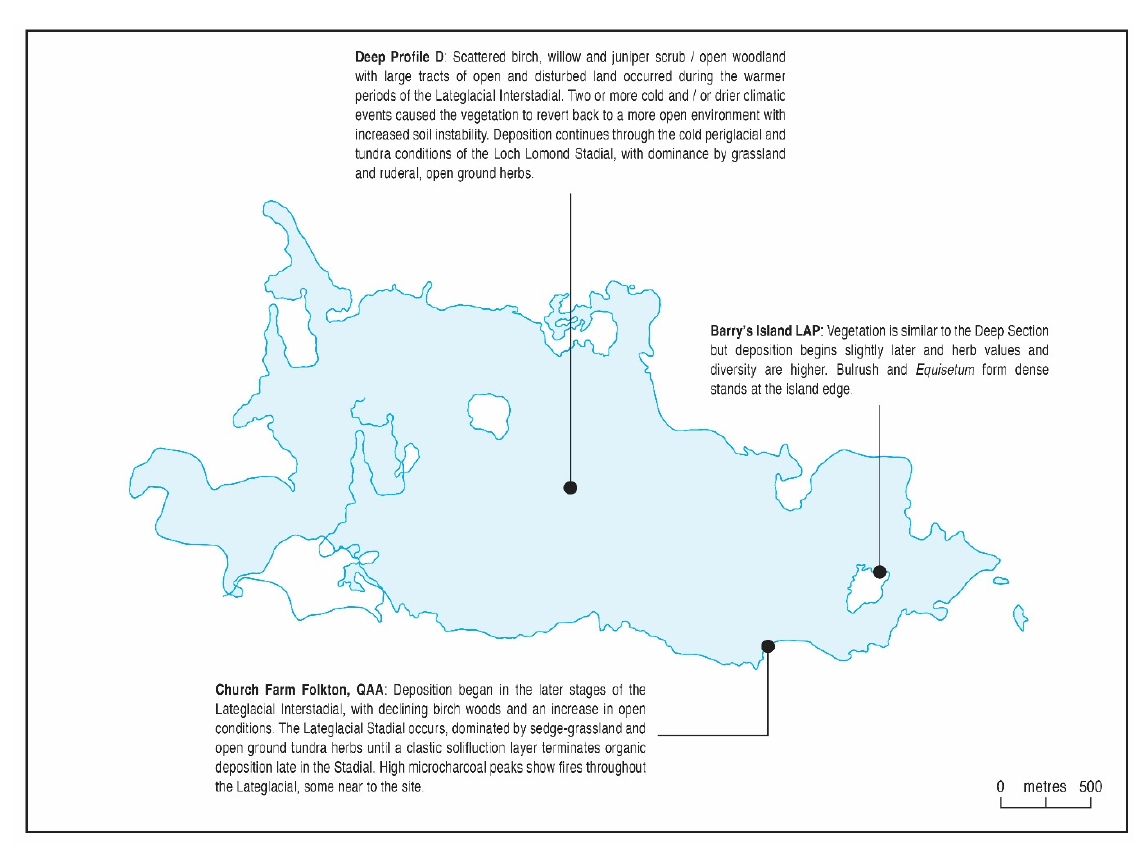
Figure 14. Correlation of palaeoenvironmental change at this paper’s sites at Palaeolake Flixton >10,000 14 C BP (Lateglacial Interstadial and Stadial), derived from zones D 1–4, QAA 4–5 and LAP 1–2.